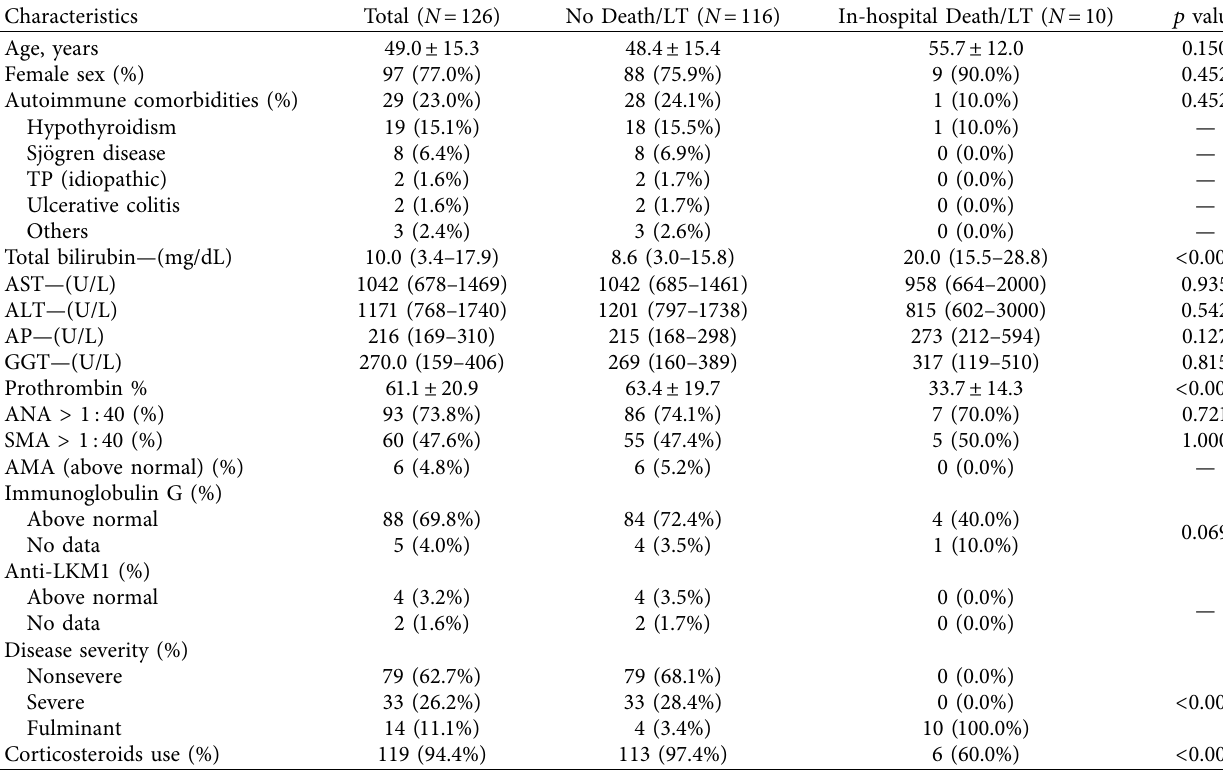
Table 2: Basal characteristics of the patients with acute autoimmune